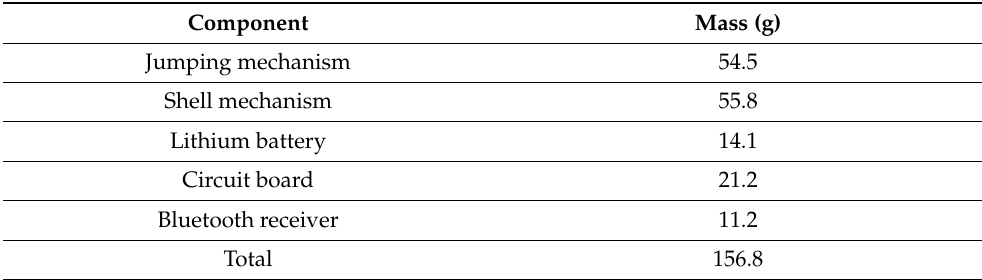
Table 1. Mass specifications of the robot’s